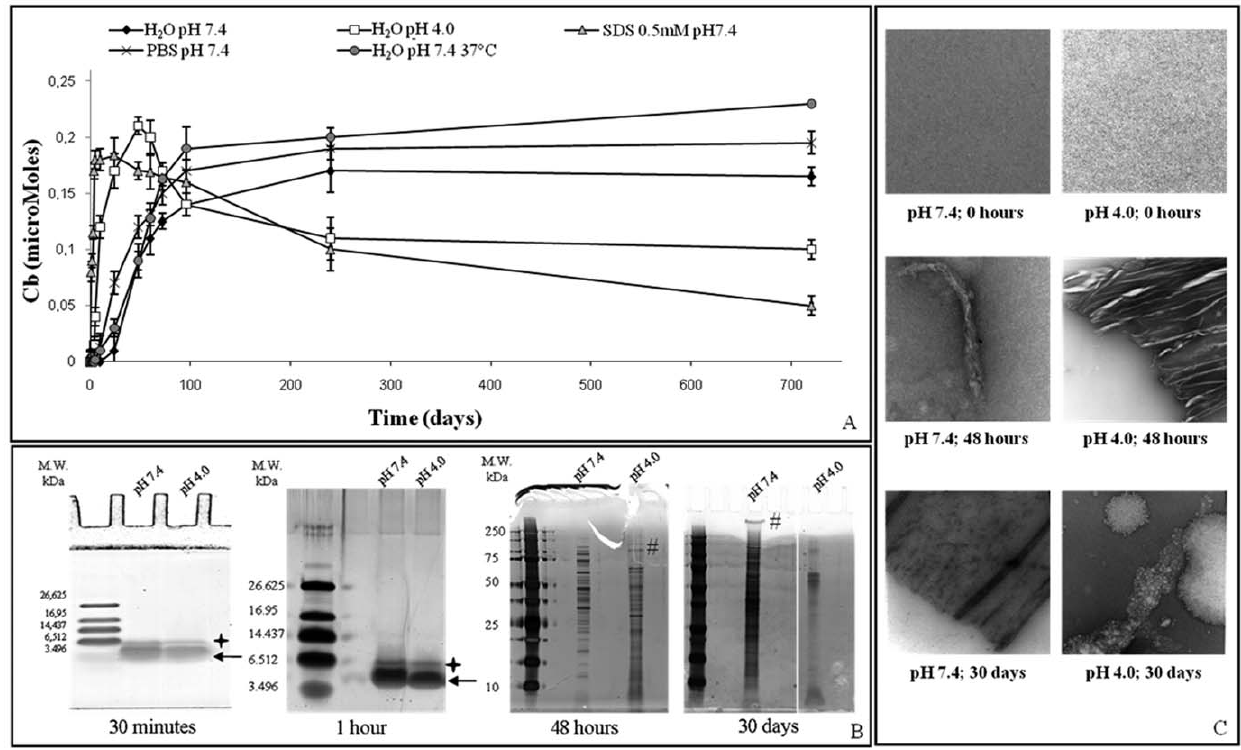
Figure 1. Aggregation kinetics. A ) Aggregationkineticsof a -ANPviaCongoredbindingmethod. Data represent the mean of at least three independent experiments (n $ 3). Errors bars represent standard deviations B ) GlutaraldehydeCross-linking,Tris-tricineSDS-PAGEandSDS-PAGE atdifferenttimes . The formation of a -ANP oligomers and high MW aggregates was monitored. Asterisks indicate dimers, arrows indicate monomers and # indicate high molecular weight aggregates. C ) Morphologyof a -ANPaggregatesatdifferenttimesandindifferentconditions. a -ANP was applied onto a copper grid and negatively stained with 2 (w/v)% uranyl acetate. Scale bar:100 nm.